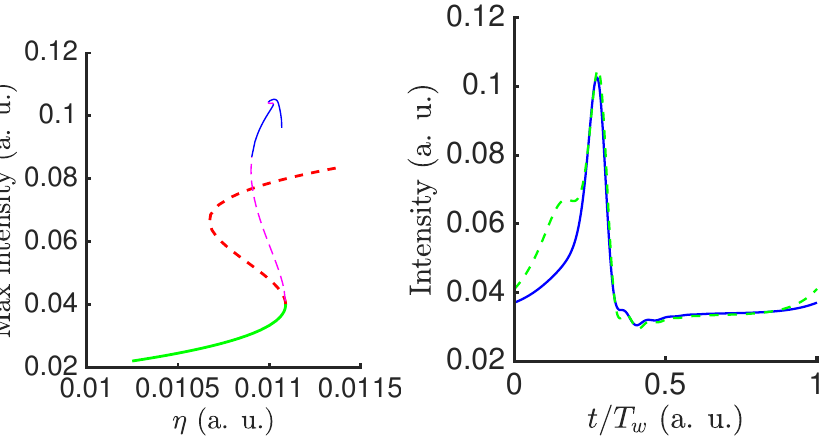
Figure 7. Left panel: One-parameter bifurcation diagram of Equation (12) with ϕ = ϕ ε , κ = κ ε , and ε = 0.2. CW (periodic) solutions are shown by thick (thin) lines. Solid lines represent stable states and dashed lines represent unstable states. The parameter η is changed near η ε defined by Equation (29). Right panel: Stable localized periodic solutions for the same η from the first (main) stable part of the periodic solution branch (solid) and the secondary stable part (dashed). Other parameters are as in Figure 6.